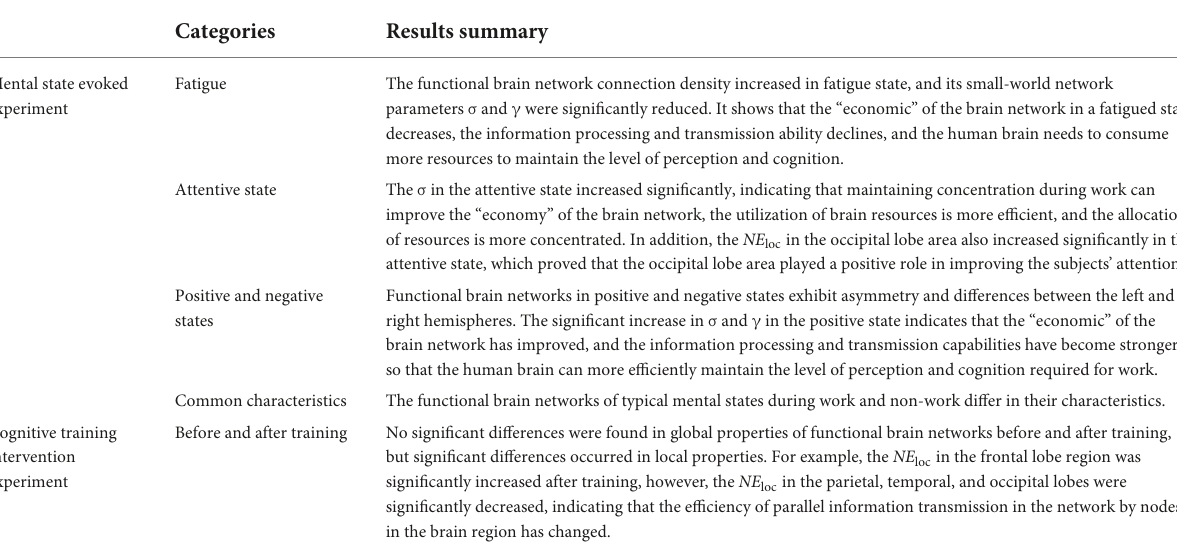
TABLE 2 Overview of experimental